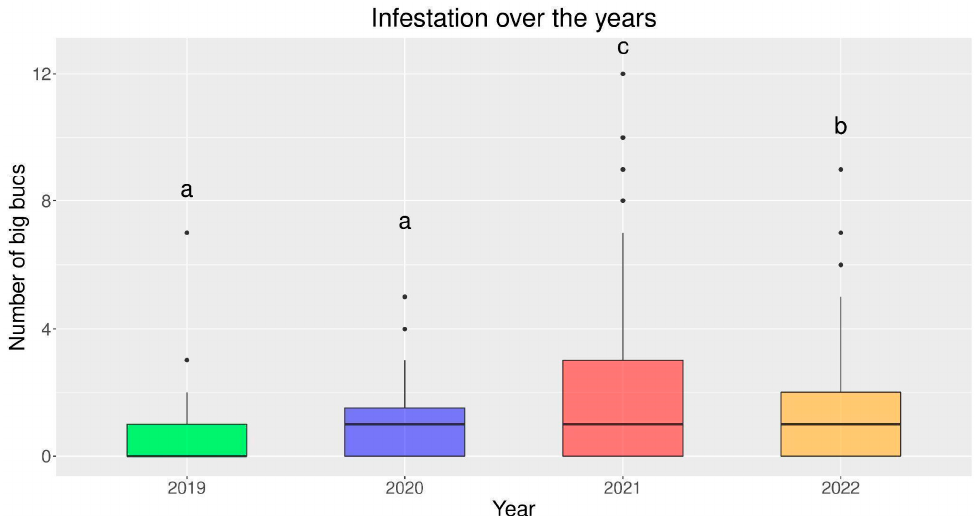
Figure 1. Overall infestation of hazelnut plants (number of big buds per plant) over the four years of survey, with no distinction between irrigated and not-irrigated plants. Different letters indicate significant difference between the year of survey after Bonferroni post hoc test at p < 0.05.